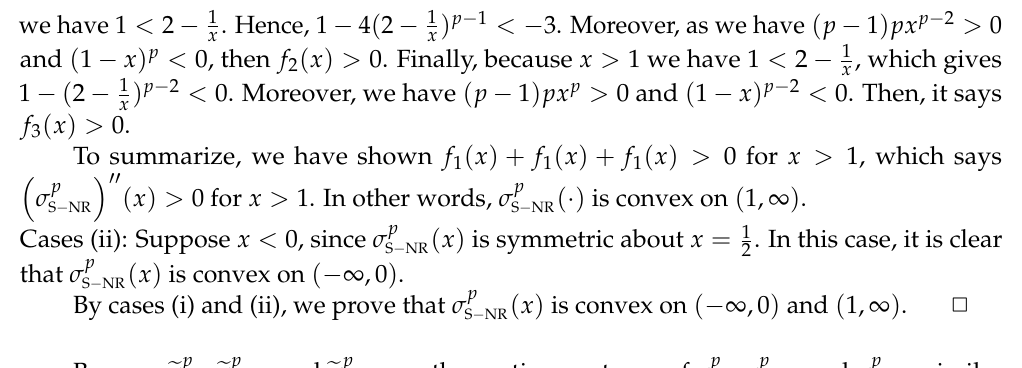
( x ) with NR with S − NR